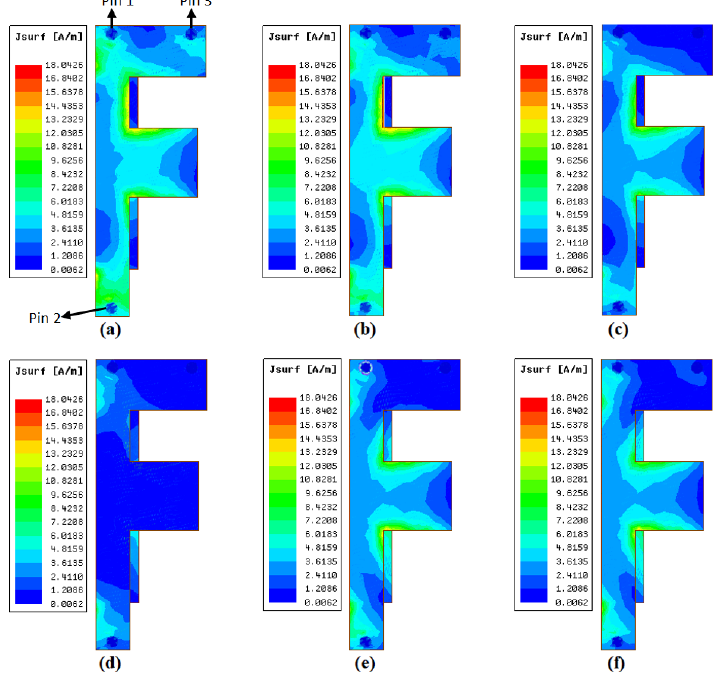
Figure 8. Current distribution on the patch at ( a ) 1.6 GHz, ( b ) 1.8 GHz, ( c ) 2.1 GHz, ( d ) 2.3 GHz, ( e ) 2.45 GHz and ( f ) 2.7